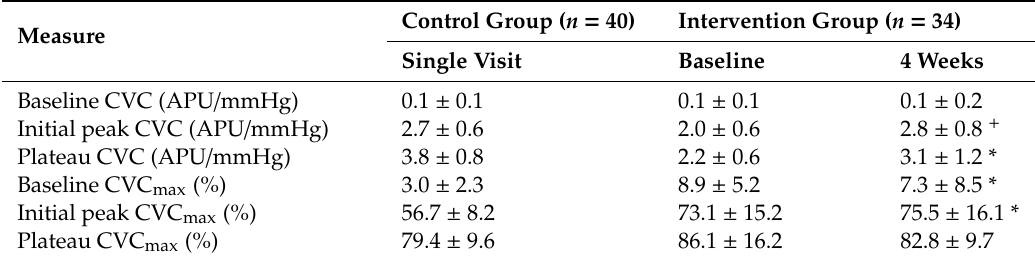
Table 4. Microcirculatory results between long- and short-term Mediterranean diet adherers (mean ± SD). Measure